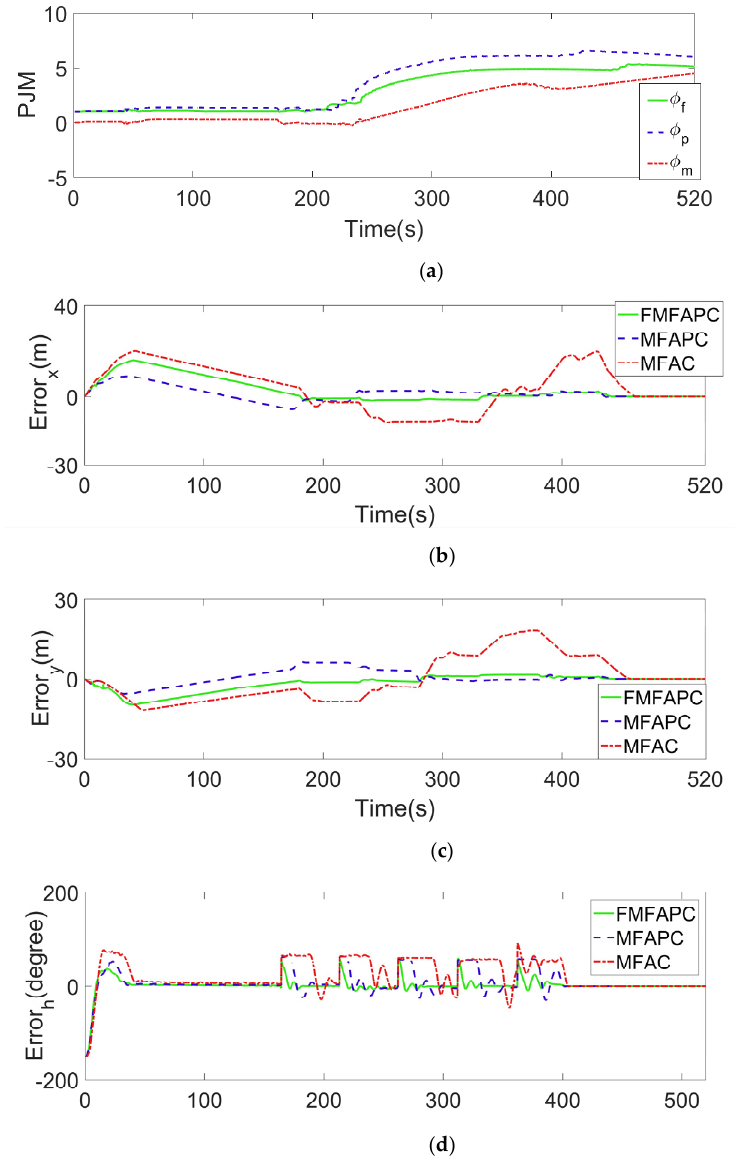
Figure 3. Simulation results of scenario 2. ( a ) Tracking results of comb ‐ shaped trajectory. ( b − d ) Control outputs. ( e − g ) Control inputs.